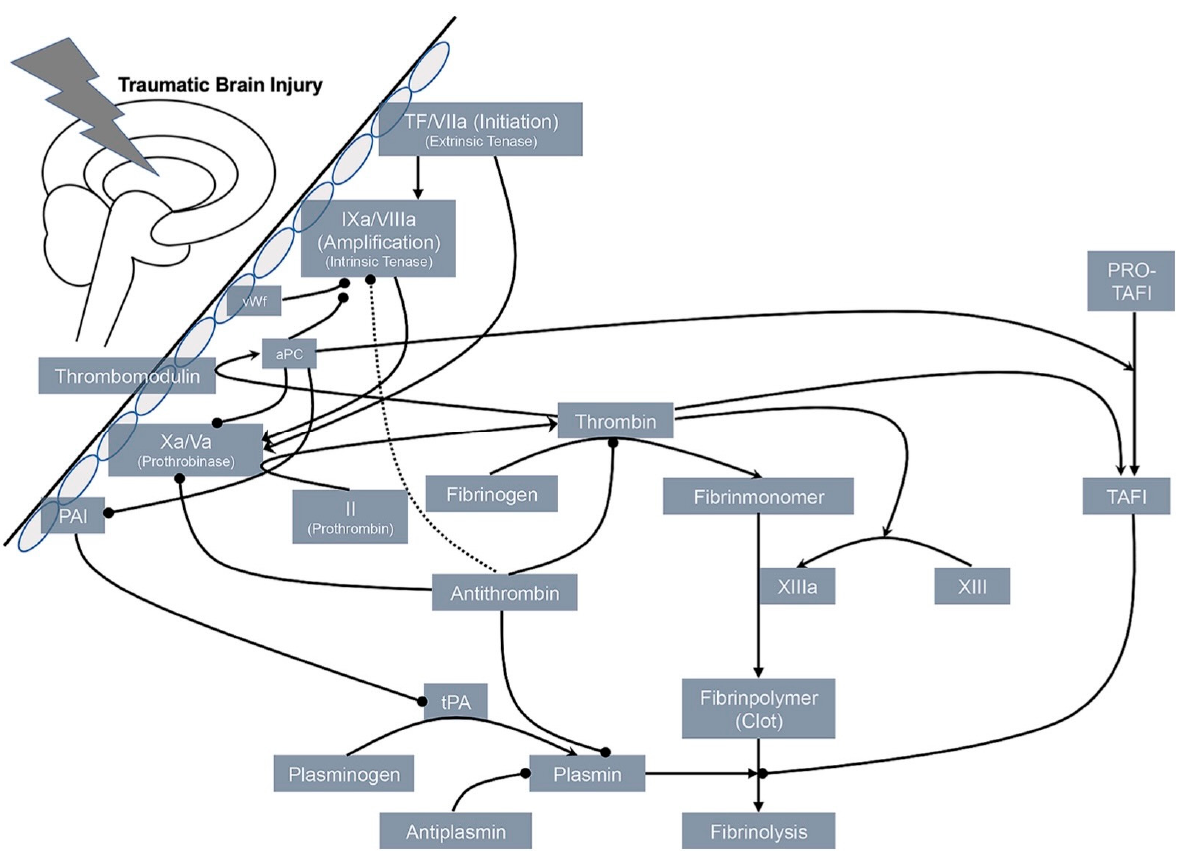
Figure 4. Summary of potential interactions and pathways involved in the development of hemostatic failure and coagulopathy after TBI. The exact nature of hemostatic disruptions observed after TBI remains elusive, but current evidence suggests the presence of both a hyper- and hypocoagulable state with possible overlap and lack of distinction between phases and states. Arrows indicate activation; bold circles inhibition. Reprinted from Maegele et al. [7], with permission from Wolters Kluwer Health, Inc.